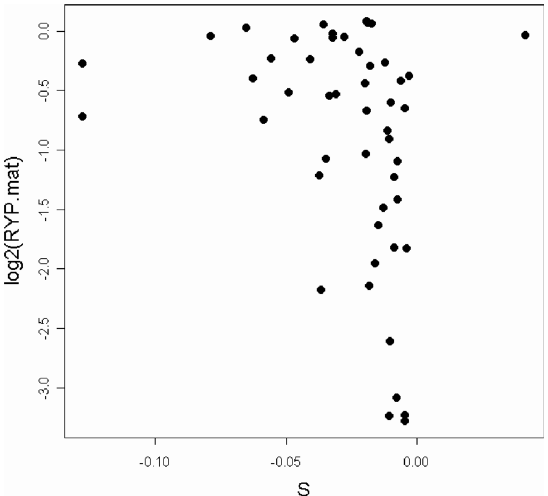
Fig. 1. A comparison of community matrix (S) entries with those of the RYP-matrix. The values are only weakly but negatively correlated (Pearson’s r = – 0.304, p < 0.05; Spearman’ rank r = –0.422, p <